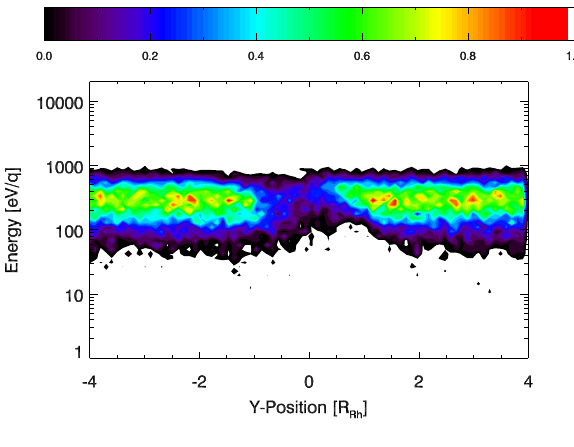
Fig. 13. Synthetic ion spectrogram along the Rhea flyby trajectory. The color represents the ion flux, normalized towards the maximum.